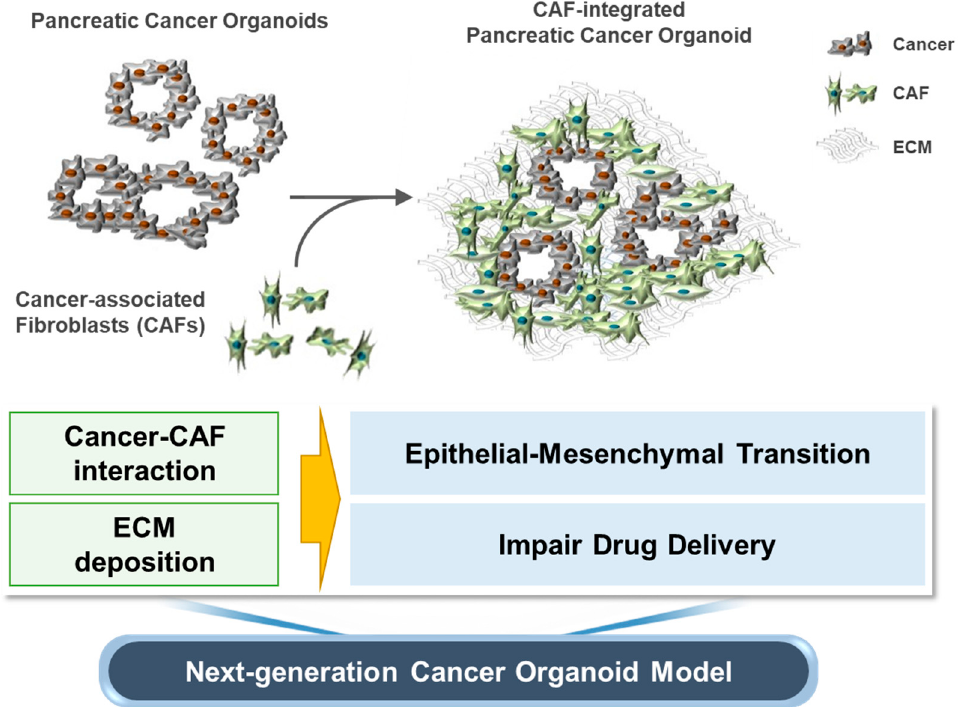
Figure 5. Schematic of the CIPCO model and summary of its characteristics.